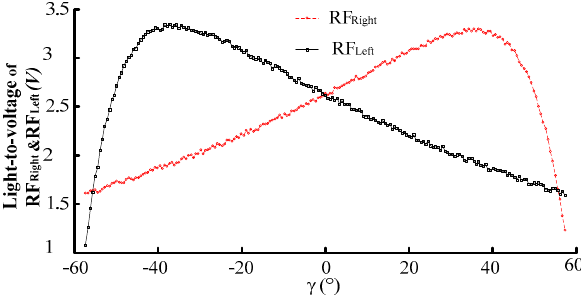
Figure 16. Error of ratio-displacement curve of the two receiving fibers’ deviation from the fitting line.